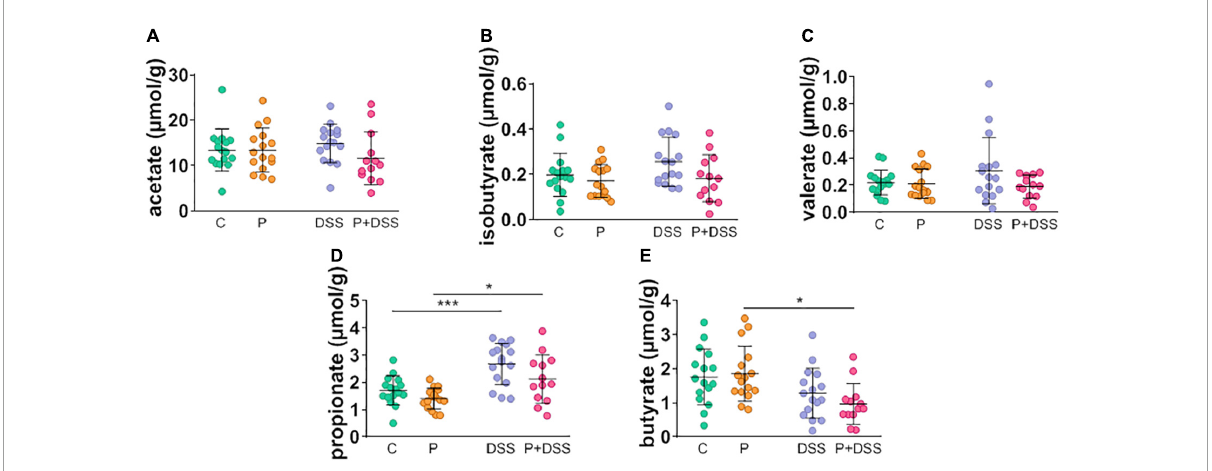
FIGURE7 Prebiotic administration to mothers decreases the caecal short-chain fatty acid butyrate concentration in offspring treated with DSS. (A–E) Impact of prebiotic supplementation and/or DSS treatment on the concentrations of different SCFAs was measured in the caecal content of all groups of mice. Data represent the mean and standard deviation of the mean of 11–17 mice per group. Two-way ANOVA, followed by Bonferroni’s post hoc comparisons tests: * p < 0.05, *** p < 0.001 (Prebiotics or DSS